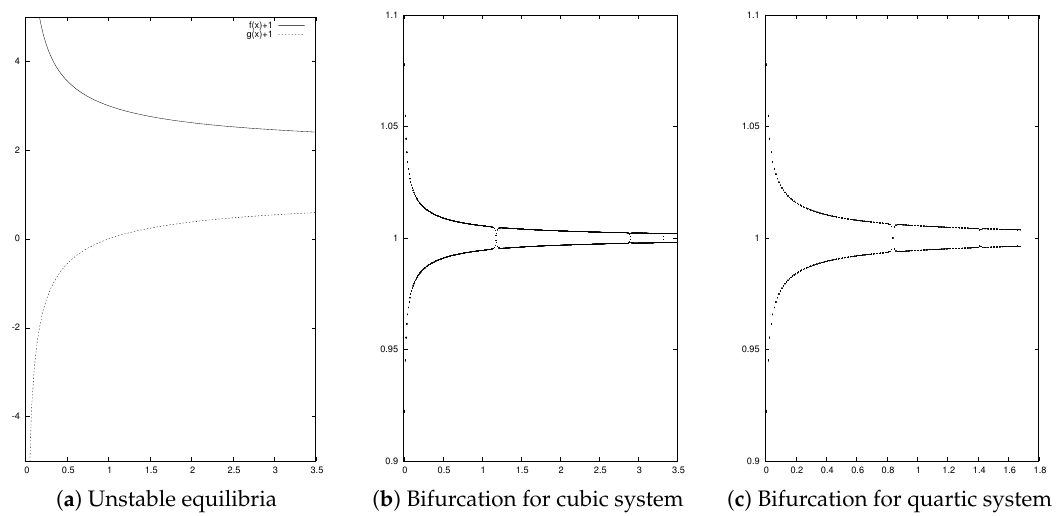
Figure 8. Bifurcation diagrams for β = 0 and initial condition x 0 = 0.3. Horizontal axis is α and vertical axis is x n